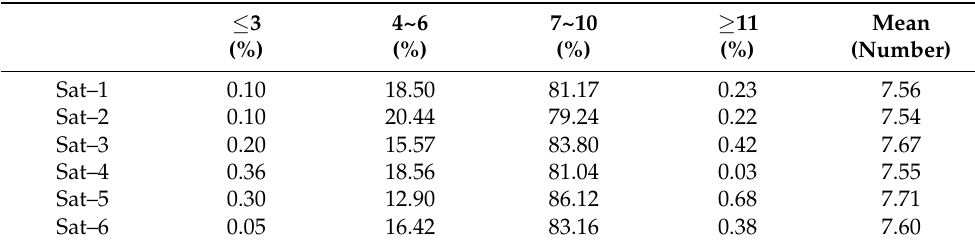
Table 1. Percentage statistics of the visible number of GPS satellites for the six COSMIC-2 satellites, DOY 138–142,